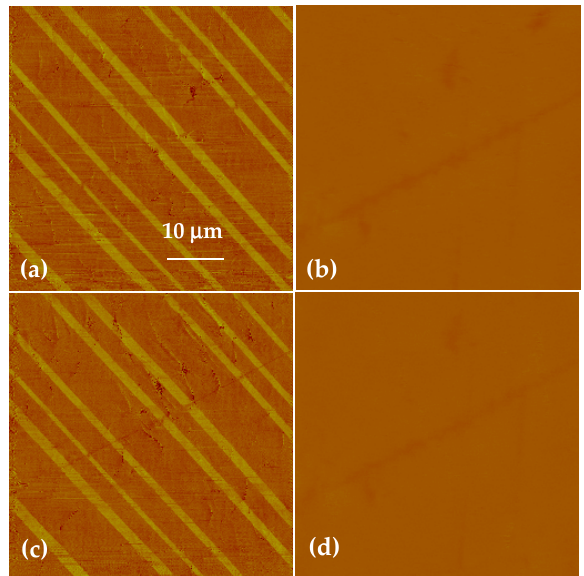
Figure 6. The PFM ( a ) and the corresponding surface potential map ( b ) of 90° a-b domain at 110 °C, and PFM ( c ) and surface potential image ( d ) after cooling to 90 °C.